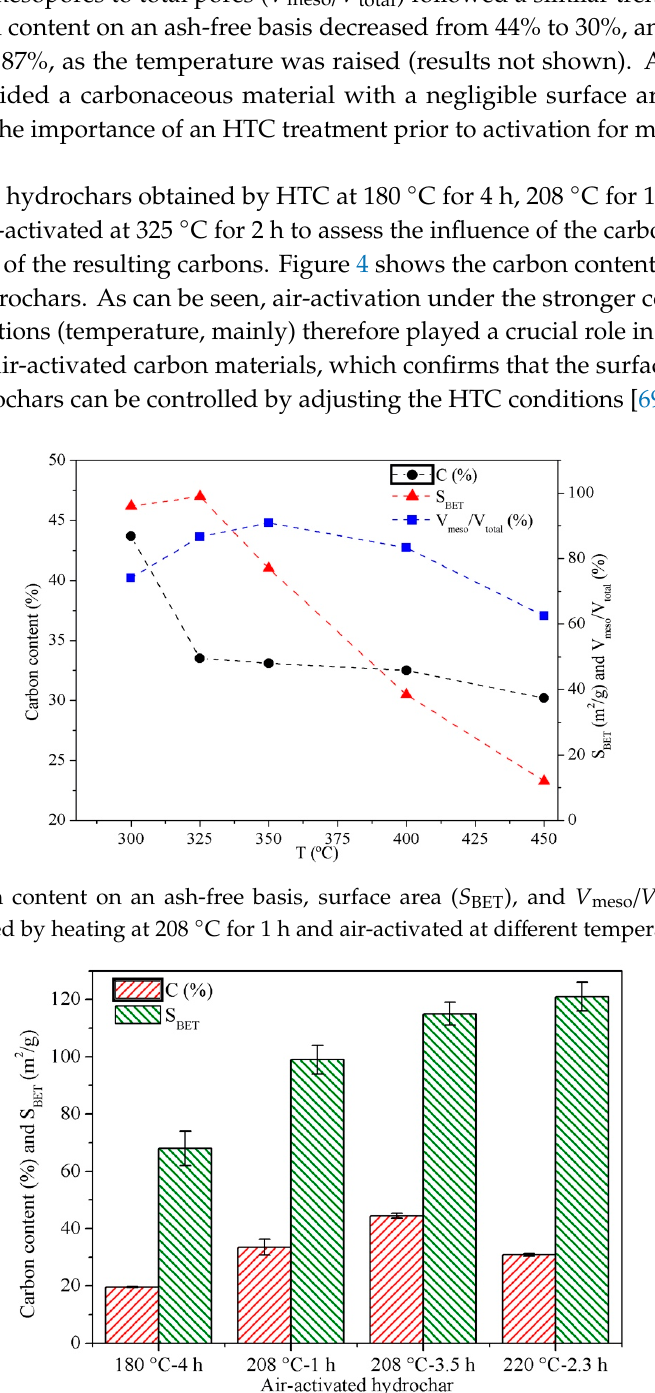
Figure 4. Carbon content on an ash-free basis and surface area ( S BET ) of hydrochars air-activated at 325 °C for 2 h.